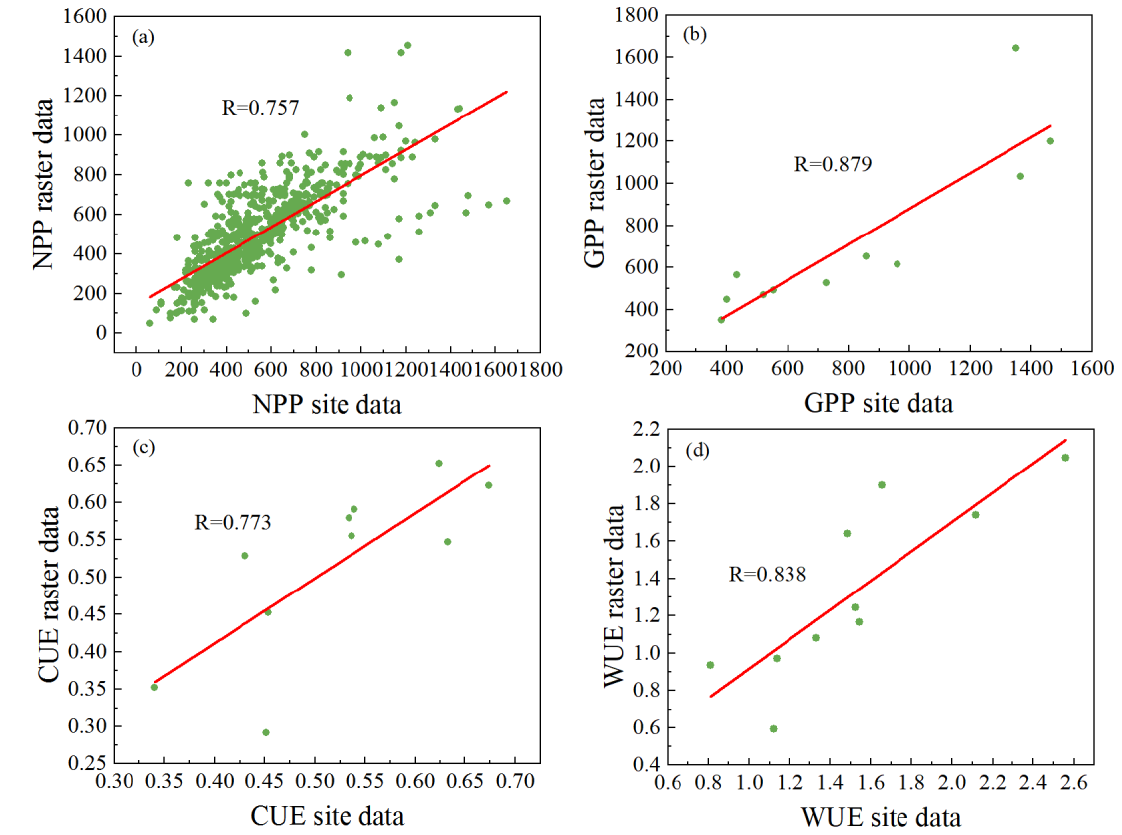
Figure 8. Scatter plots of the NPP, GPP, CUE, and WUE site data and MODIS raster data. ( a ) is the scatter plots diagram of NPP site data and raster data; ( b ) is the scatter plots diagram of GPP site data and raster data; ( c ) the scatter plots diagram of CUE is calculated from the site data and raster data; ( d ) scatter plots of WUE calculated from site data and grid data raster data.